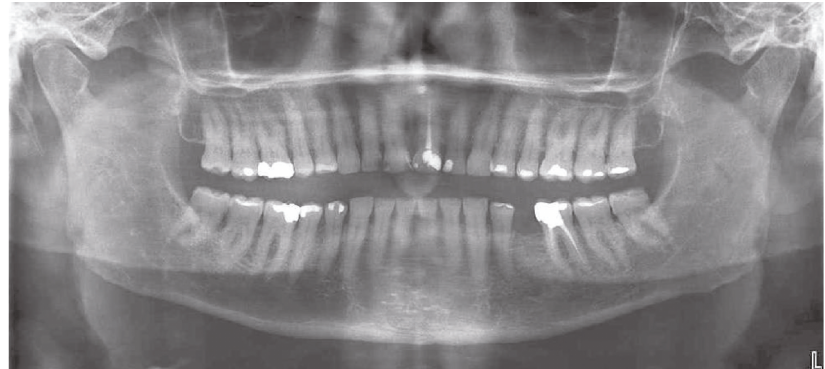
Figure 5: Initial panoramic view.